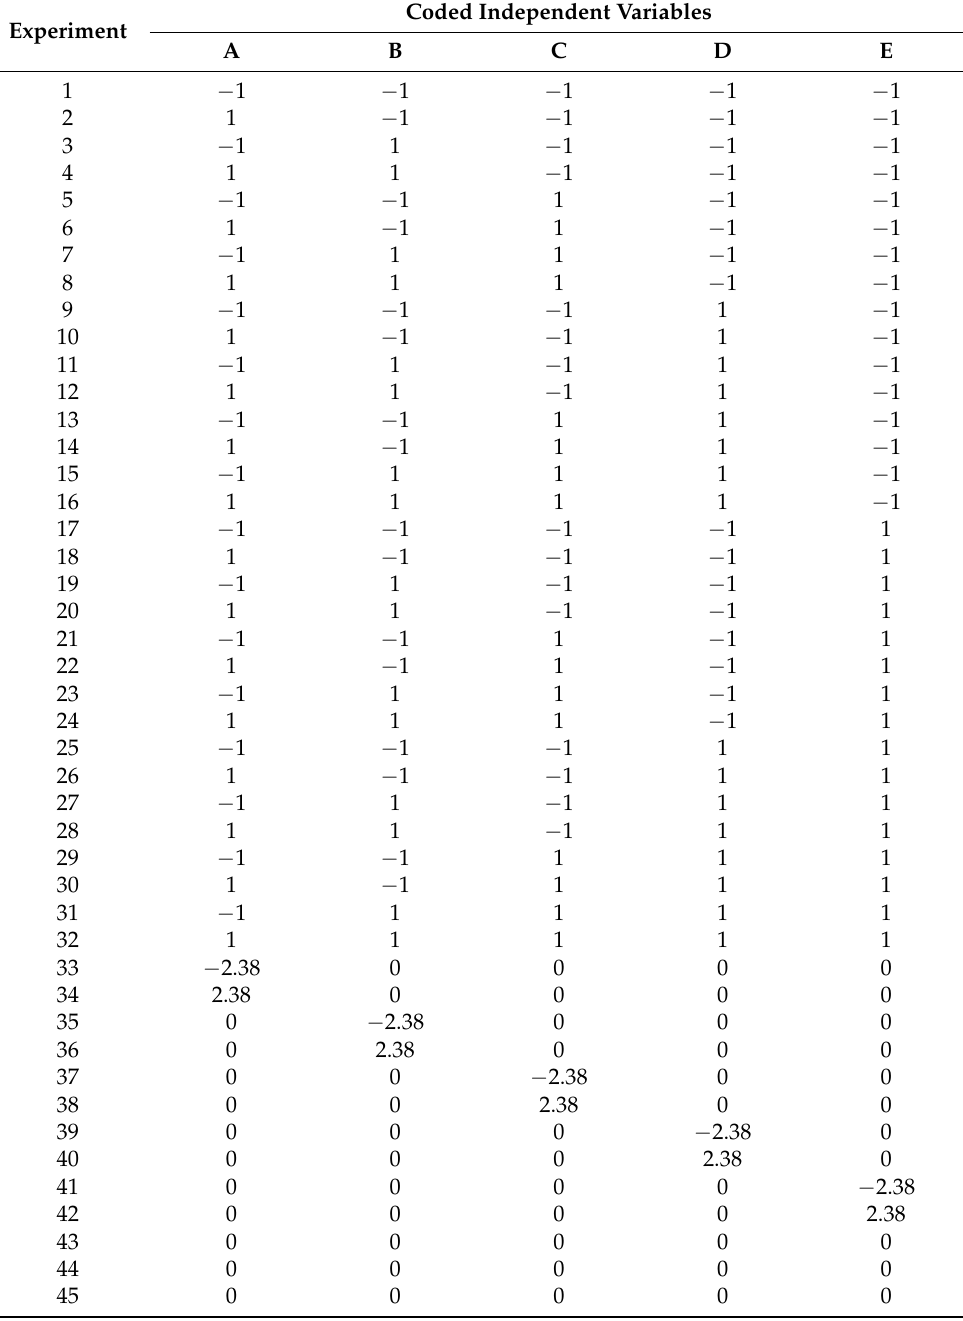
Table 8. Experimental matrix of the full rotatable central composite design 2 5 (coded values) (inde- pendent variables are presented in Table 7). Coded Independent Experiment